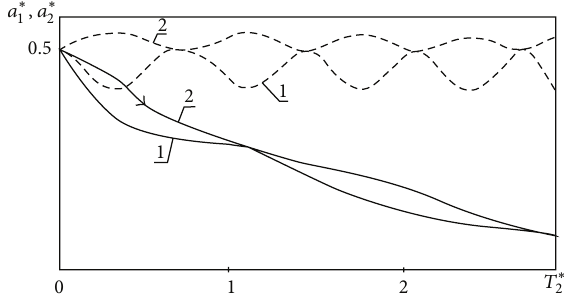
Figure 3: The 𝑇 ∗ 2 -dependence of the dimensionless amplitudes of vibrations for the case of 1:1 internal resonance.